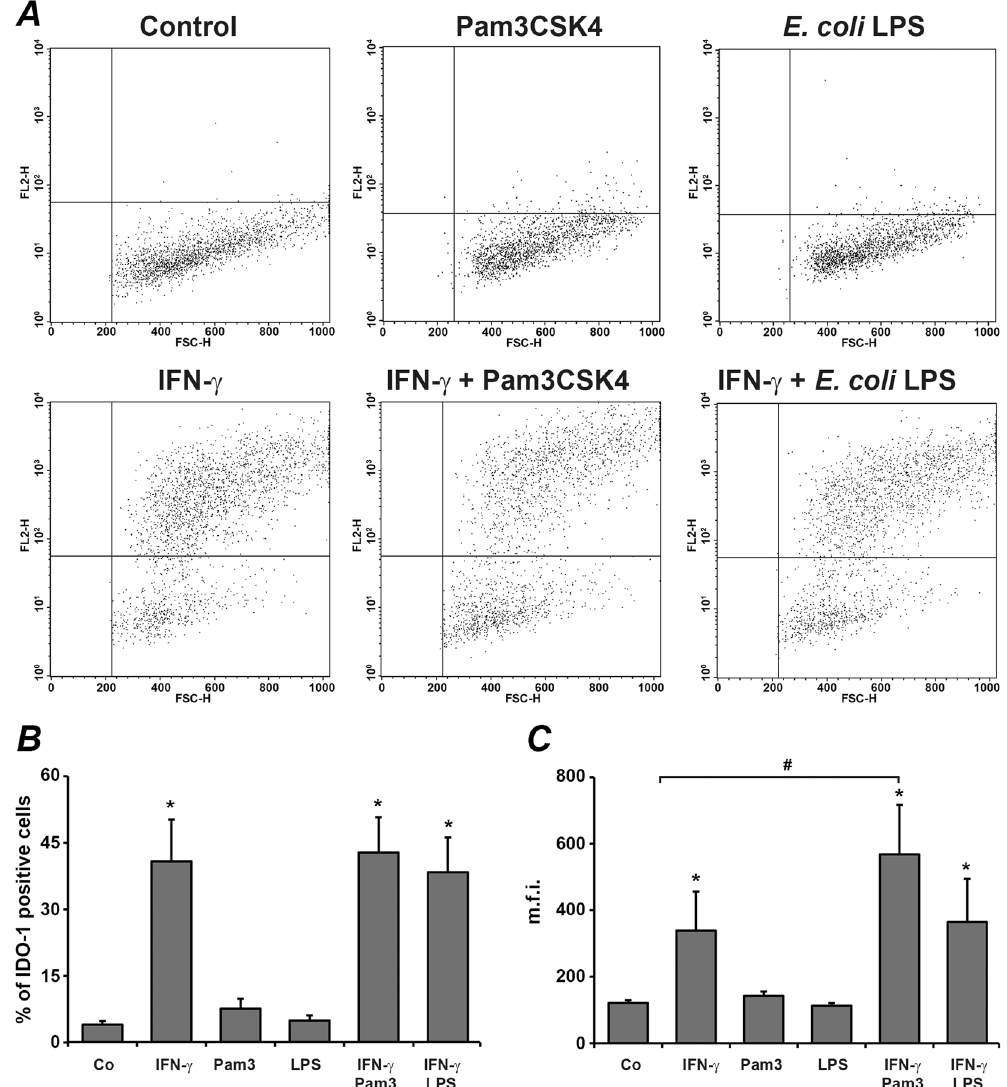
Figure 2. Effect of IFN- γ , Pam3CSK4, and E. coli LPS on intracellular expression of IDO-1 in human periodontal ligament stem cells. Cells were stimulated with IFN- γ (10 ng/ml), TLR2 agonist Pam3CSK4 (1 µ g/ml), TLR4 agonist E. coli LPS (1 µ g/ml), or combinations of IFN- γ and TLR agonists for 48 h. After stimulation, cells were stained intracellulary with anti IDO-1 antibody and proceeded to flow cytometry analysis. ( A ) original FACS dot plots of hPDLSCs stained intracellularly with anti-human IDO-1 antibody after stimulation with different stimuli. ( B ) percentage of hPDLSCs stained positively with anti-human IDO-1 antibody. ( C ) mean fluorescence intensity of hPDLSCs positively stained with anti-human IDO-1 antibody. Data are presented as mean ± s.e.m. of 6 different donors. * significantly different compared to control, p < 0.05. # significantly different between groups, p <